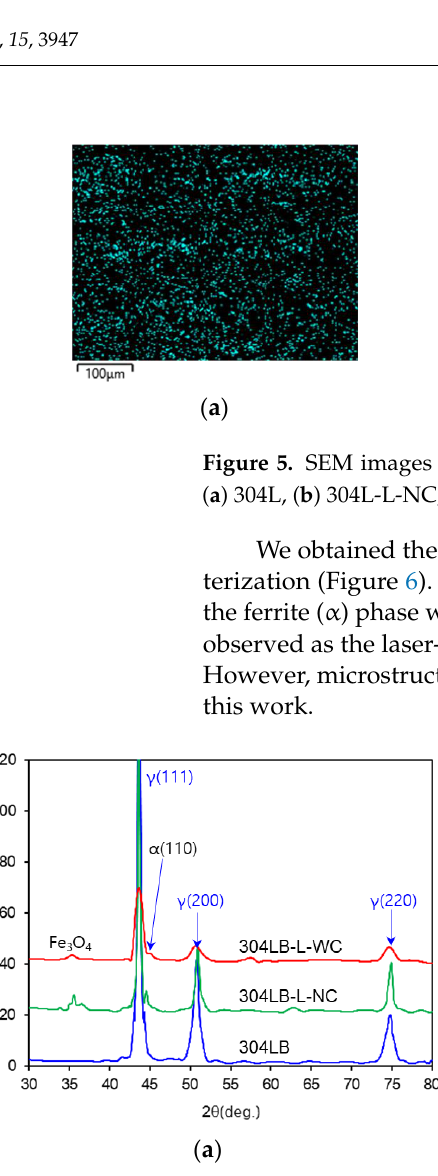
Figure 6. The X-ray diffraction patterns of 304L stainless steel after LP: ( a ) base metal, ( b ) weldment.